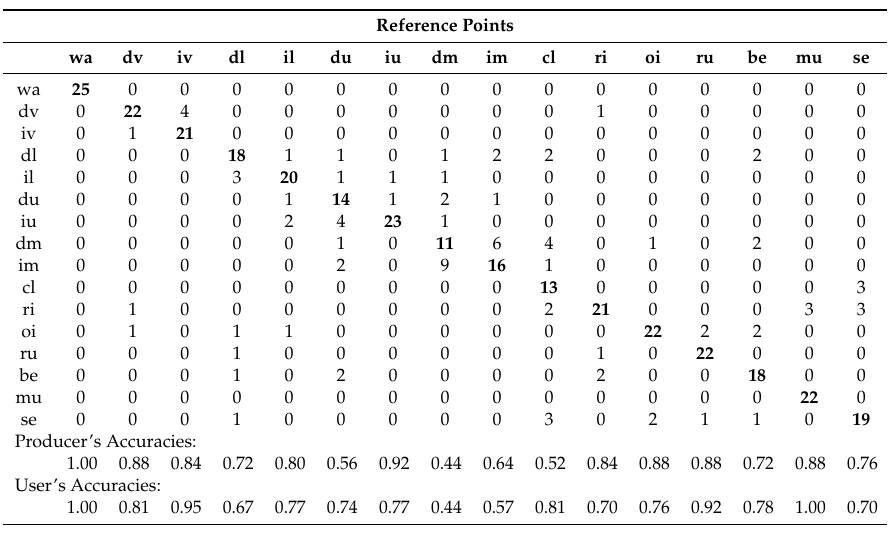
Table 3. Confusion matrix from the Gaussian Maximum Likelihood Classification (GMLC) for 16 land use/land cover classes. Numbers of correctly classified reference points (withheld training data) are shown in bold along the main diagonal. Land use/land cover codes are: wa, water; dv, degraded mangrove; iv, intact mangrove; dl, degraded lowland evergreen forest; il, intact lowland evergreen forest; du, degraded upland evergreen forest; iu, intact upland evergreen forest; dm, degraded mixed deciduous forest; im, intact mixed deciduous forest; cl, clearing/bare ground; ri, rice; oi, oil palm; ru, rubber; be, betal nut; mu, mudflat; se, human